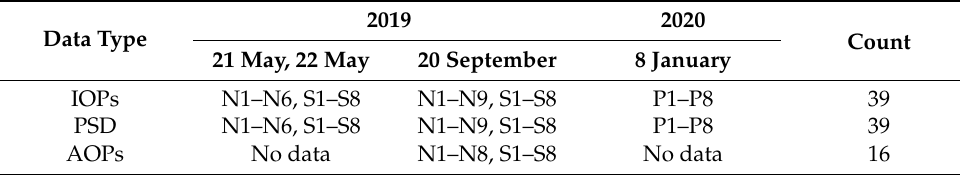
Figure 1. Study area and sampling sites. Table 1. Observation stations with respect to three trips, including IOP, PSD, and AOP data. Data